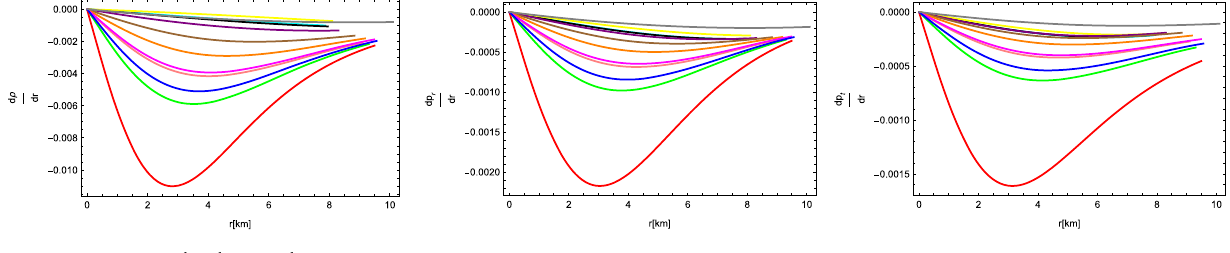
Fig. 3 Variation of d ρ